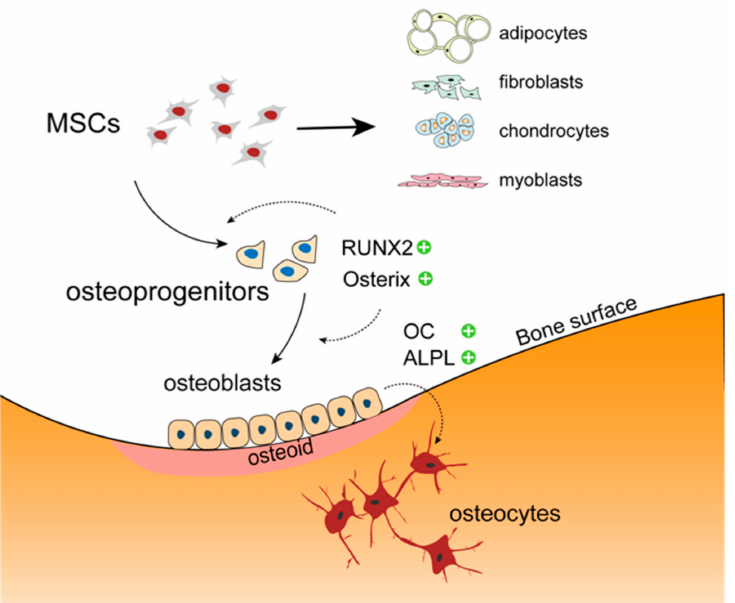
Figure 1. Osteoblasts are derived from mesenchymal stem cells (MSCs), precursor cells also giving rise to chondrocytes, adipocytes, myoblasts and fibroblasts. Osteoblasts aggregate along bone surfaces to synthesize osteoid. Runt-related transcription factor (RUNX2) is one of the key transcription factors required for osteoblastic differentiation and is highly expressed at both early and late stages of differentiation. Osteocalcin (OC) produced by osteoblasts is expressed during bone mineralization. Alkaline phosphatase (ALPL) represents the key enzyme for driving bone matrix mineral deposition. RUNX2 is one of the key transcription factors required for osteoblastic